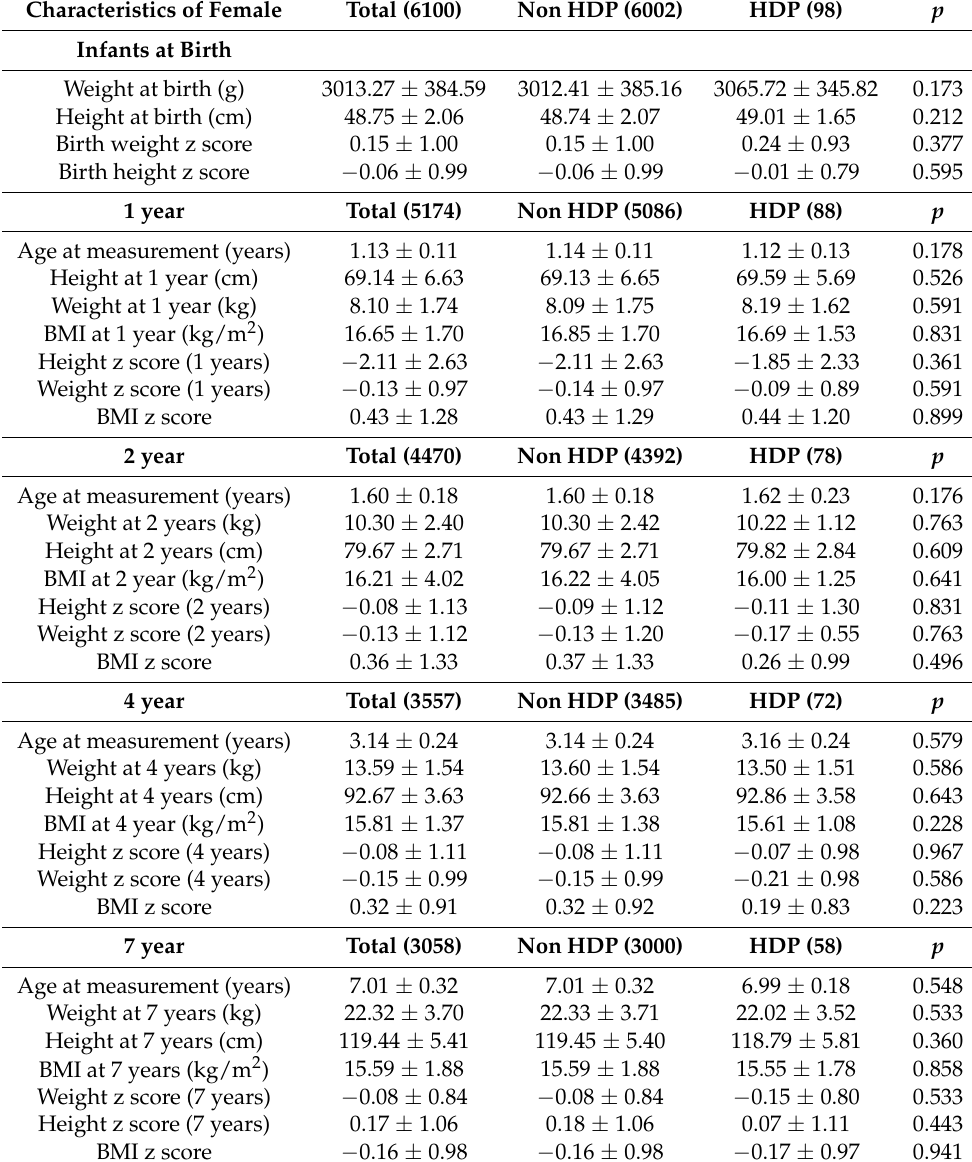
Table 3. Demographic information on female children from birth to seven